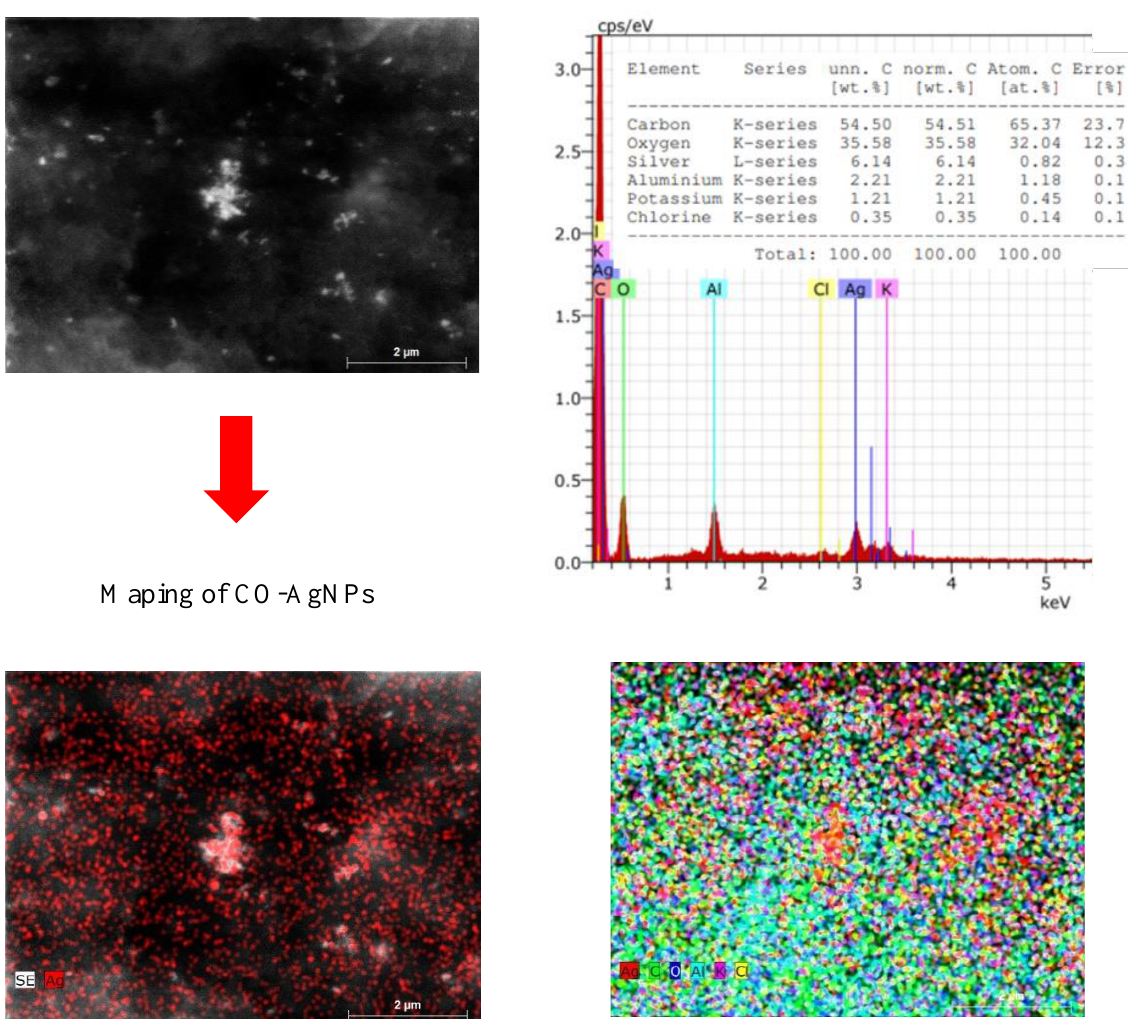
Figure 5. SEM images and EDS spectra of AgNPs biosynthesized using extracts of Calendula . The formation of silver nanoparticles is confirmed by images and the EDS